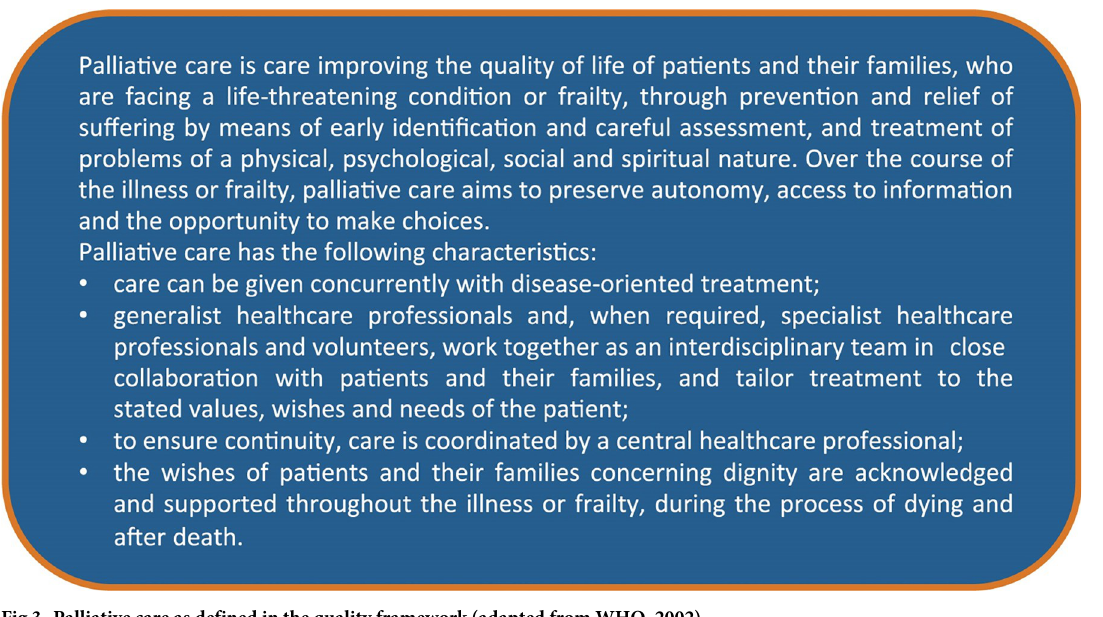
Fig 3. Palliative care as defined in the quality framework (adapted from WHO,